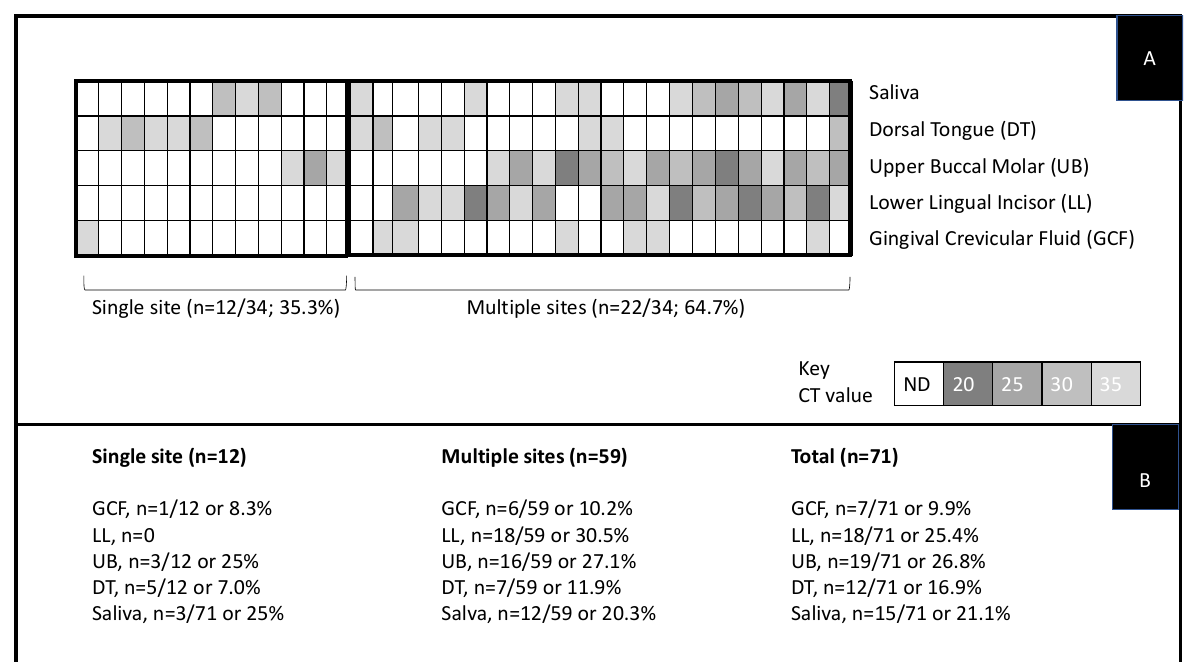
Figure 1. qPCR screening of samples for positive control 16S rRNA. All study samples harbored bacterial DNA with average cycle threshold (CT) counts ranging from 28.6 (saliva and lower lingual incisor), 29.9 (dorsal tongue), to 30.1 (upper buccal molar and gingival crevicular fluid).